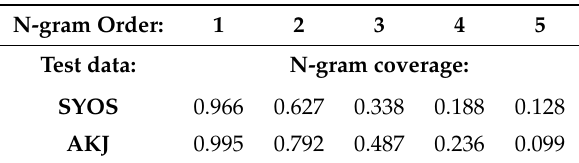
Table 10. N-gram coverage.